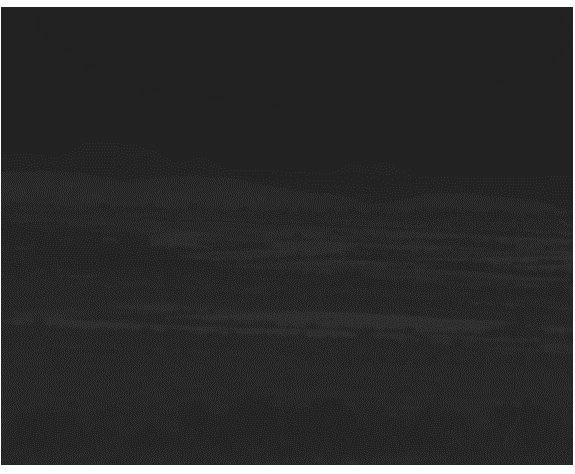
Figure A1. 16-bit raw frame.